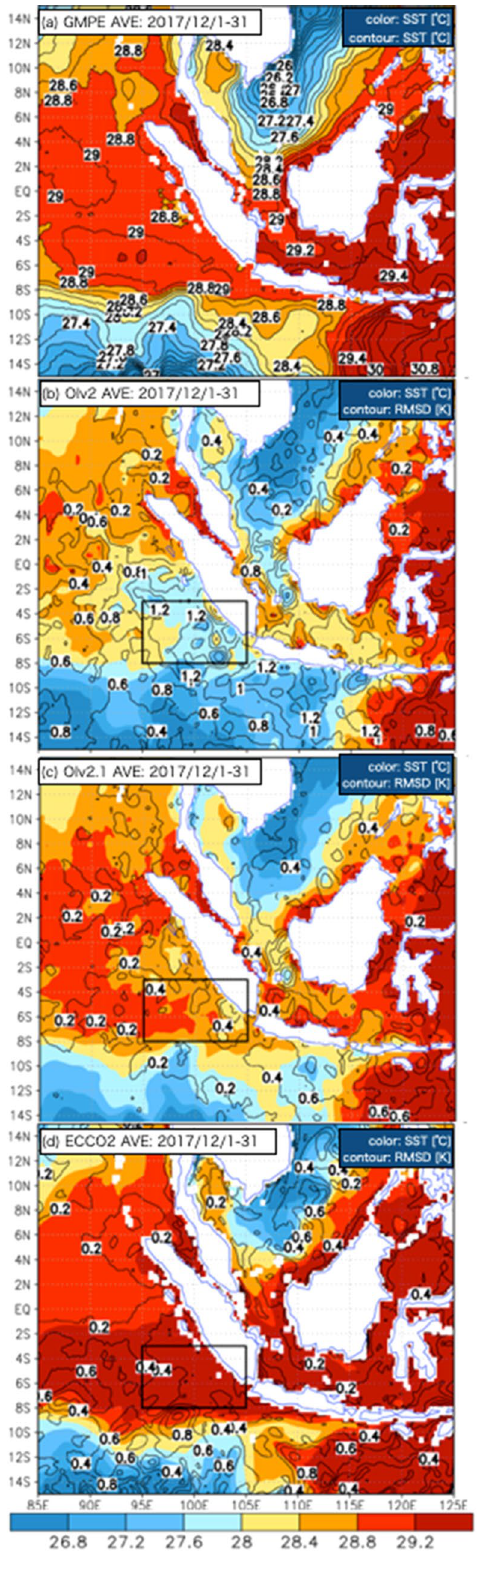
Figure 4. ( a ) GMPE (color and contours every 0.2 K), ( b ) OIv2, ( c ) OIv2.1, and ( d ) ECCO2 for 1–31 Dec. 2017. The RMSD with respect to GMPE is indicated with contours every 0.2 K in ( b – d ). Spatial correlation and regression values with respect to GMPE calculated for the box from 3–8° S 95–105° E are shown at the top right corner of each panel in ( b )-( d